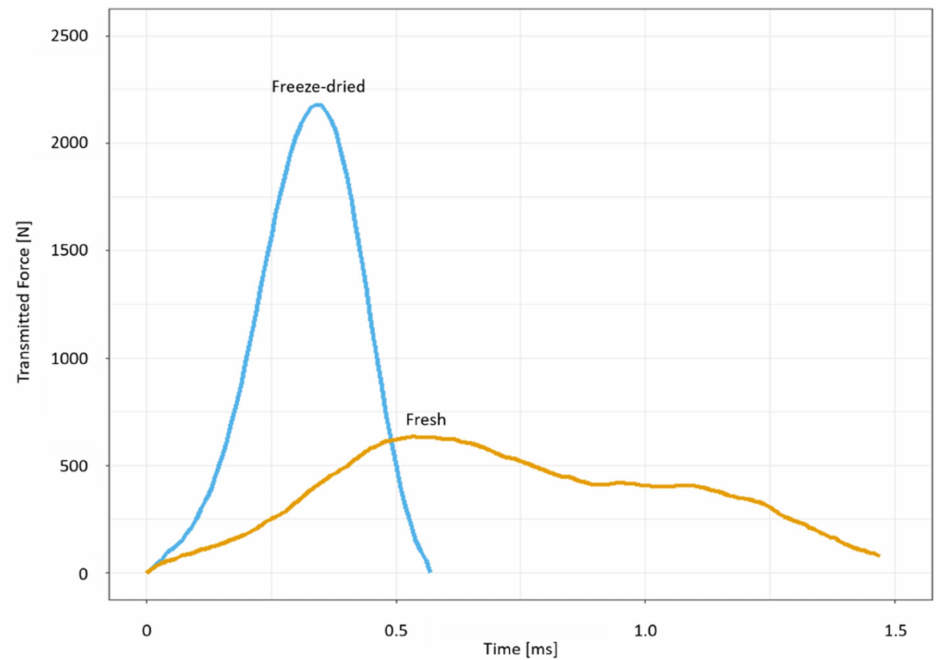
Figure 5. Characteristic force-time diagrams of a drop-weight test for a fresh and a freeze-dried sample of Citrus × limon . The area under each graph characterizes the impulse of the impact. The impactor (mass = 0.061 kg) was dropped from a height of 0.81 m onto the samples. The transmitted force maximum of the impact has a median value of 837.13